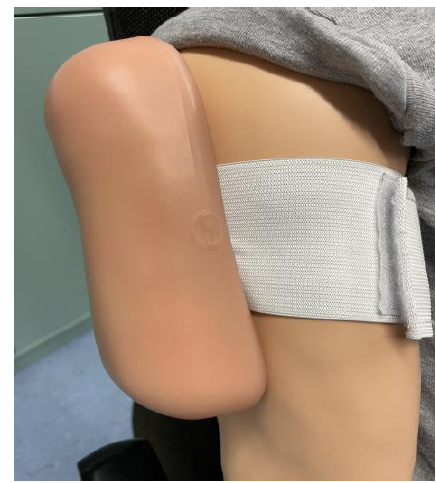
Figure 1. Low-fidelity Simulator.